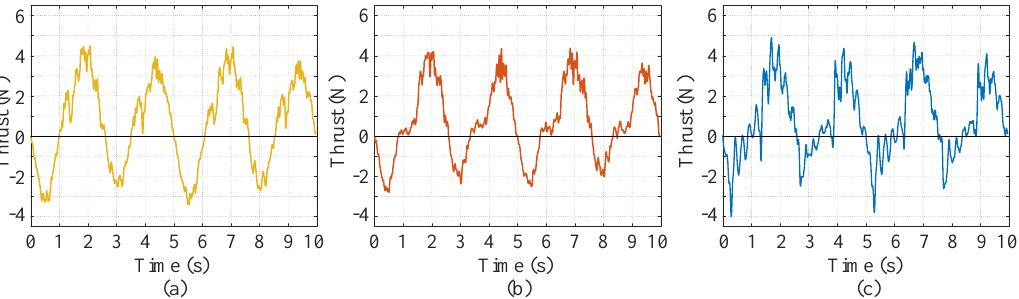
Figure 8. Instantaneous thrust of the three deformation patterns when A = 45° and f = 0.20 Hz. ( a ) Conventional nondeformable mode. ( b ) Sinusoidal-based mode. ( c ) Instant mode.